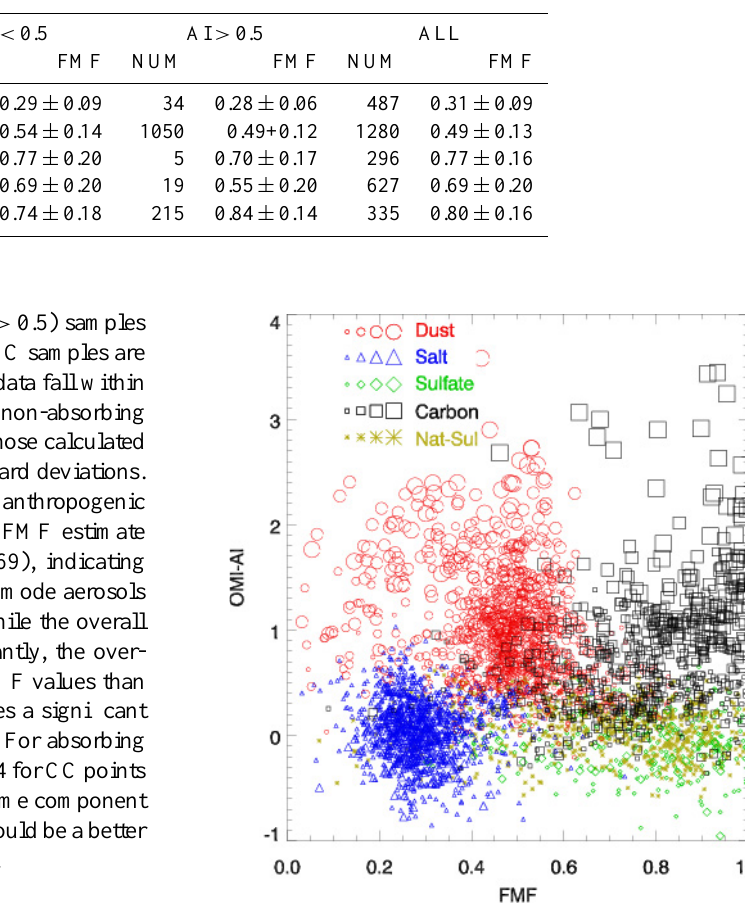
Fig. 4. OMI-AI as a function of MODIS FMF color-coded by aerosol type, with increasing symbol sizes representing larger MODIS AOT in bins of (0.0 < 0.3; 0.3 < 0.6; 0.6 < 0.9; and AOT >